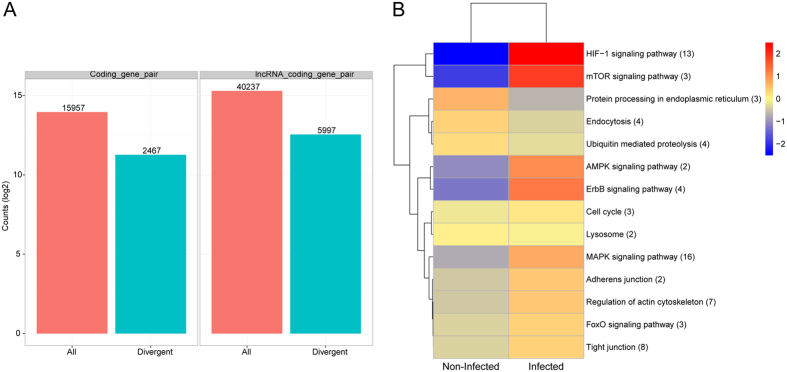
Analysis of lncRNA functional annotation.(A) Number of gene pairs formed by lncRNAs and mRNAs located close together in the genome. (B) KEGG annotation of the functions of genes in the vicinity of lncRNAs. Red shows higher expression and blue shows lower expression. The number of differentially expressed genes in the signalling pathway is shown in parentheses.